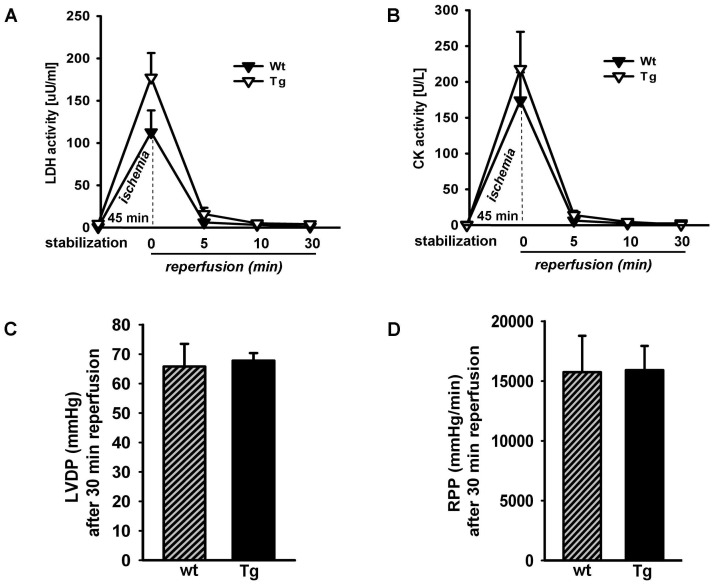
Assessment of ex vivo ischemia reperfusion injury by Langendorff isolated heart perfusion in (P)RR Tg mice.A) Leakage of lactate dehydrogenase (LDH) before and after ischemia and 5, 10 and 30 min after reperfusion of Wt and Tg mice. No significant difference was found between Wt and Tg mice. B) Leakage of creatine kinase (CK) before and after ischemia and 5, 10 and 30 min after reperfusion of Wt and Tg mice. No significant difference was found between Wt and Tg mice. C) Functional recovery; LV developed pressure (LVDP) for Wt and (P)RR Tg hearts after 30 min of reperfusion. D) Rate–pressure product (RPP) for Wt and (P)RR Tg hearts after 30 min of reperfusion. Values are means ± SEM; n = 6 per group.